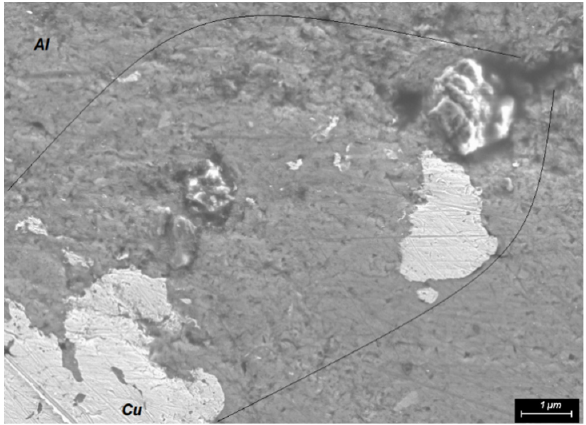
Figure 3. The inter-mixing zone resulting from intensive shear of constituents under high hydrostatic pressure (black lines show the boundary of the intermixing zone where random islands of copper within the aluminium can be seen).